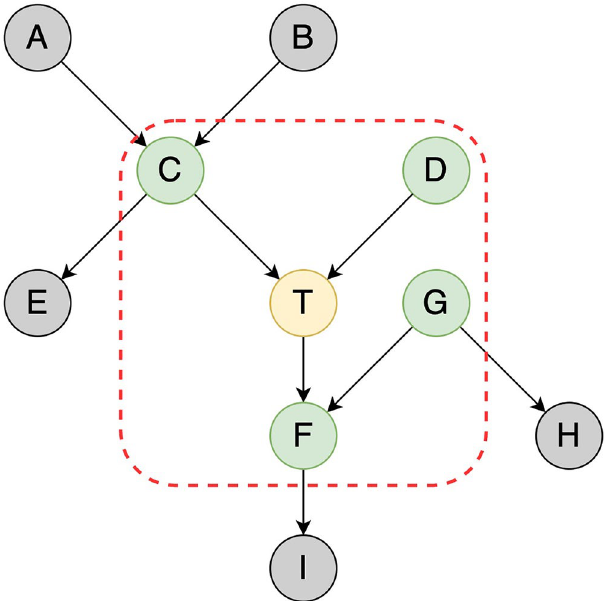
Figure 2. The diagram of an example of Markov blanket in a casual network. The T node with yellow color in the red rectangle is a target node, the other nodes form a Markov blanket of T node, and T node is independent of any node outside the